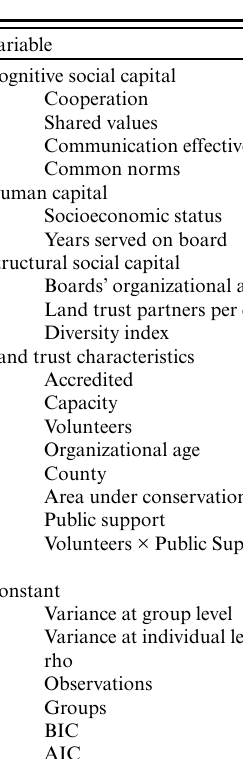
Table 5 . Multilevel model results for perceived land trust success.